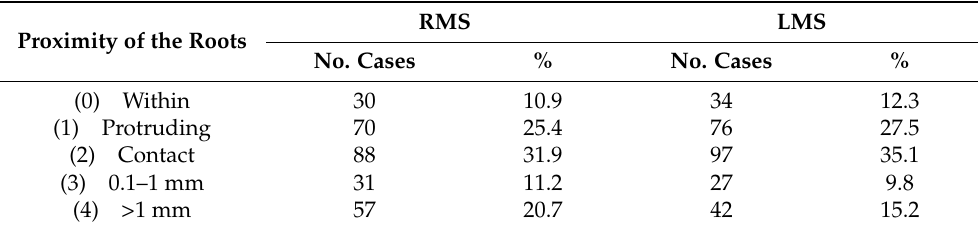
sinus by number of cases and percentages.